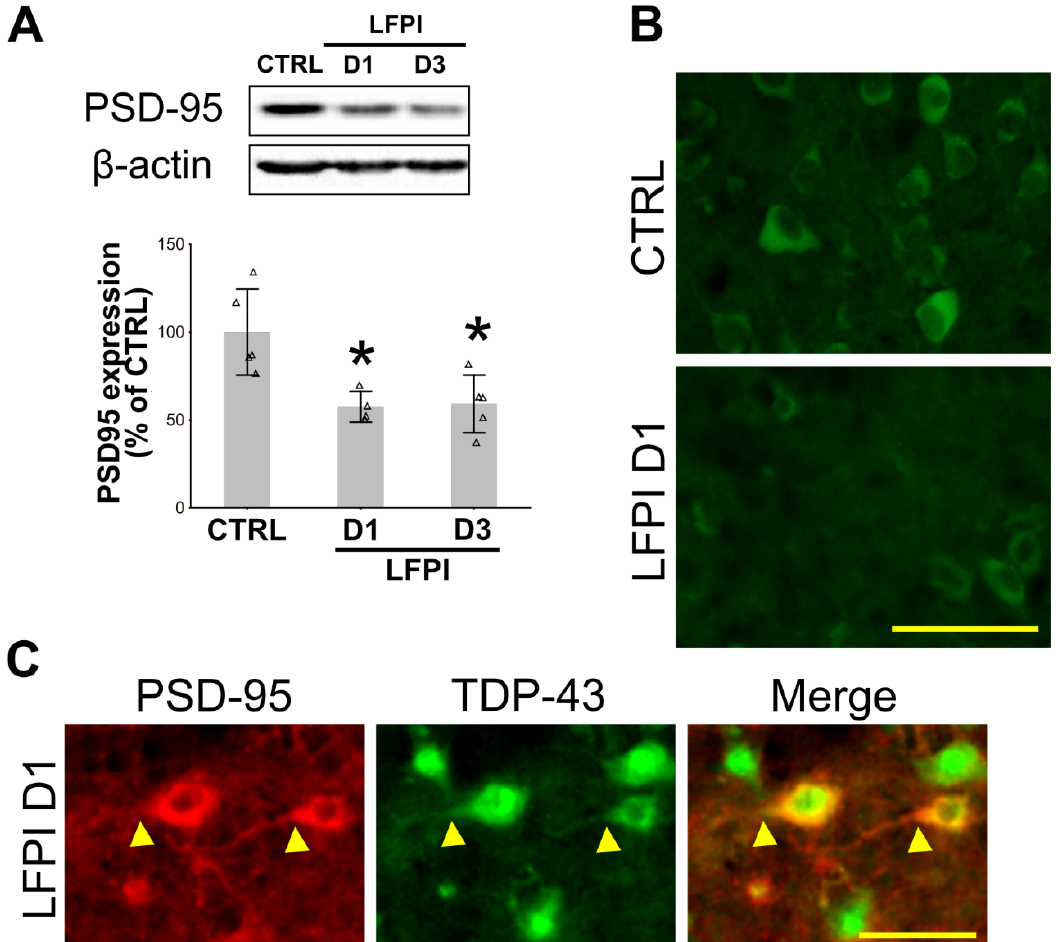
Figure 3. Changes in the cortical expression of the postsynaptic density protein 95 (PSD-95) at 1 and 3 d following single moderate lateral fluid percussion injury (LFPI) in mice: ( A ) Representative immunoblots of PSD-95 and β -actin and the bar plots of their corresponding densitometric analyses in animals sacrificed at d 1 (D1) or 3 (D3) after trauma and in the mice of the control group (CTRL) are shown. In the densitometric analyses, PSD-95 results were corrected for the values of β -actin and presented as % of the related control group. Error bars represent ± SD ( n = 4–5 mice per group). Each triangle represents data from an individual mouse * p < 0.05; significantly different from the control group. ( B ) Representative microphotographs show PSD-95-immunostained ipsilateral cortical sections in the animal of the control group and the mouse sacrificed 1 day after the LFPI. Scale bar: 50 µ m. ( C ) Double immunofluorescence of the ipsilateral cortex section from the injured mouse sacrificed 1 day following LFPI using the PSD-95 (red) and TDP-43 (green) antibodies. Arrowheads point to cells with increased cytoplasmic TDP-43 staining and pronounced PSD-95 expression. Scale bar: 50 µ